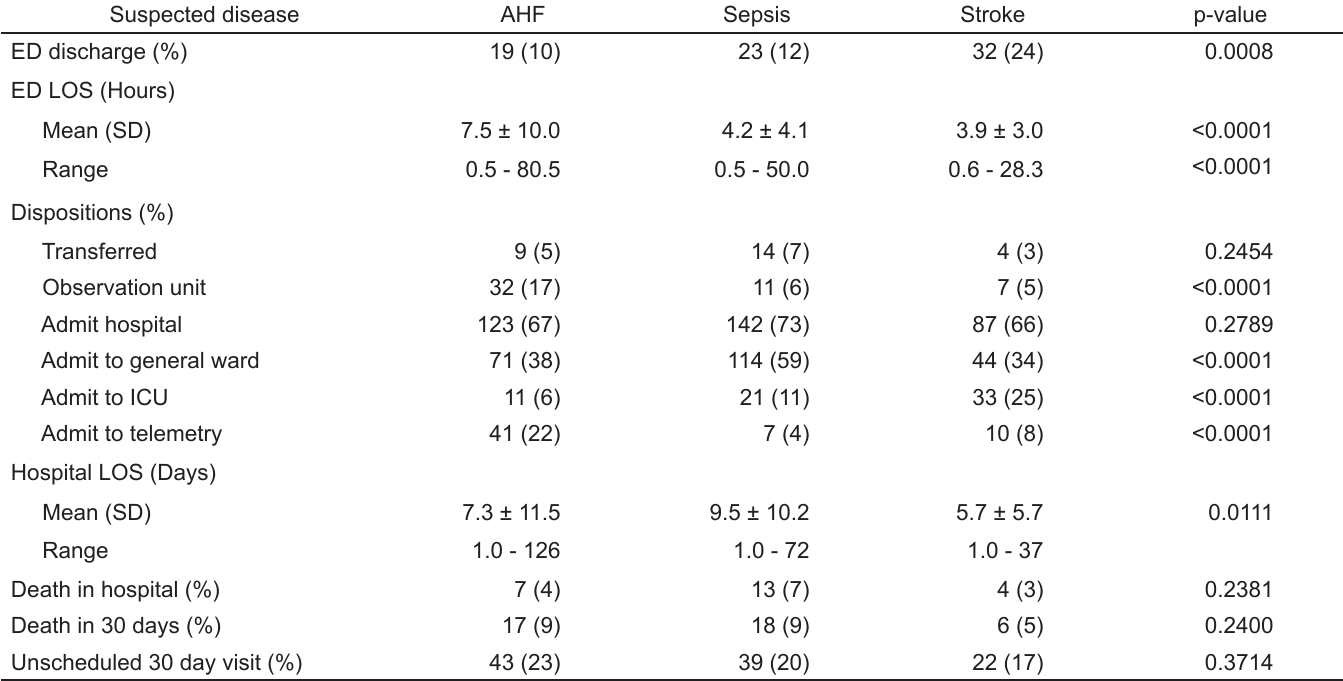
Table 2. Patient disposition, length of stay (LOS) and